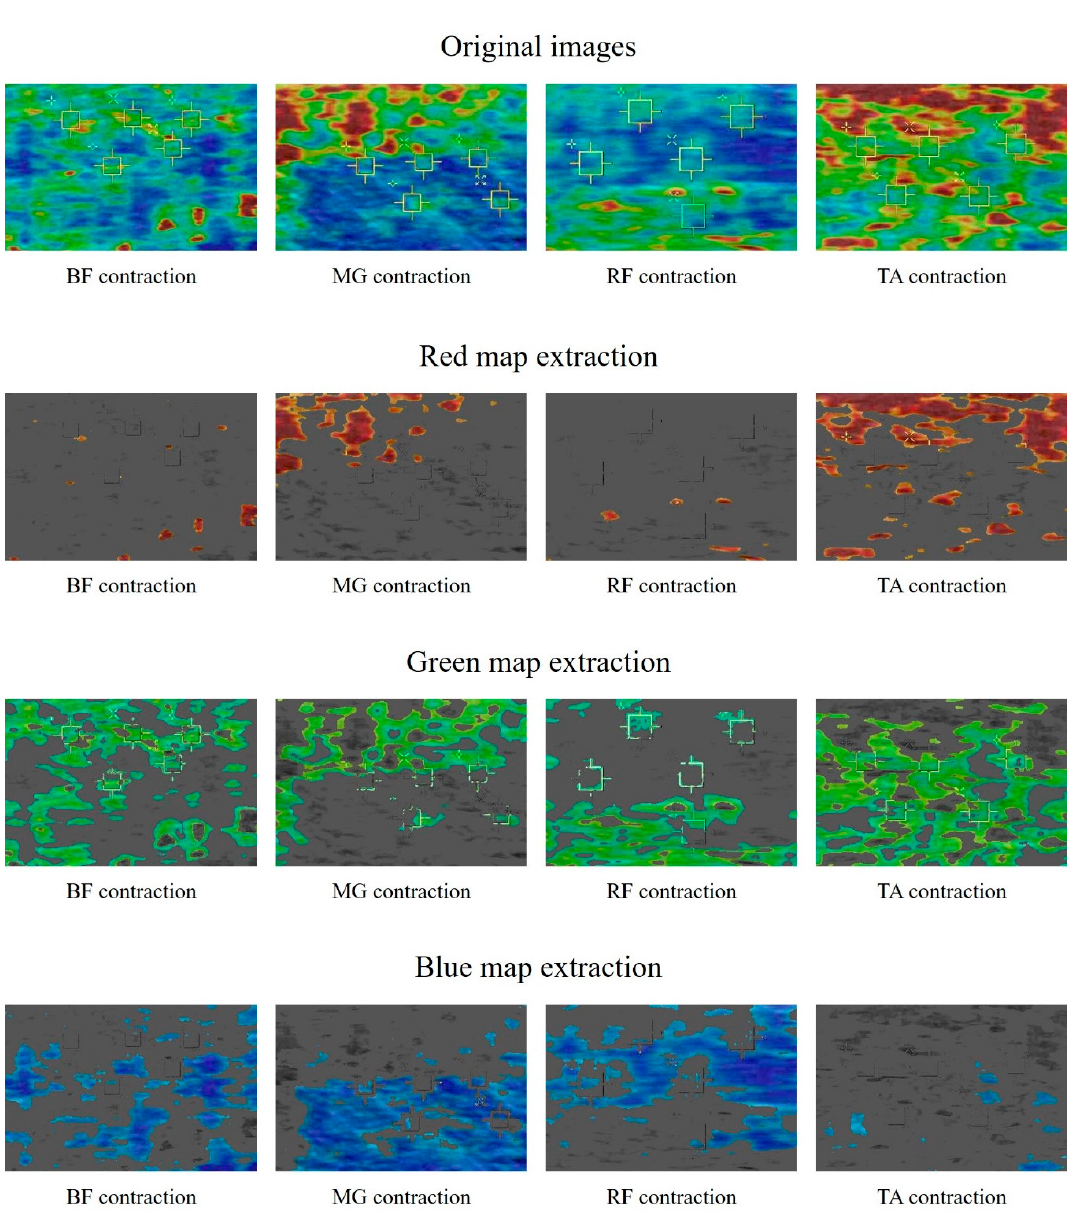
Figure 4. Acquired example images using shear wave elastography for contracted BF, MG, RF, and TA. The images show original red, green, and blue colors and the extraction results for each color. Based on the color extracted images, we evaluated the quantitative data for each color ratio with the major lower limb muscles (Figure 5 and Table